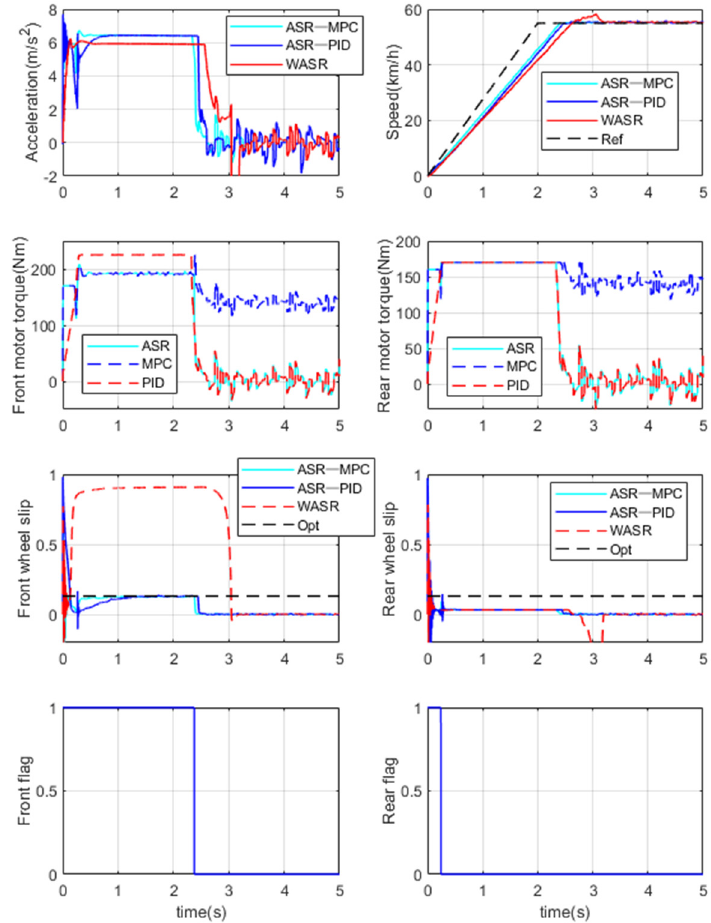
Figure 8. Vehicle starts under a high adhesion coefficient road. As shown by the results, ASR-MPC and ASR-PID are more dynamic than WASR and has a faster speed response. In ASR-MPC control, the NMPC is turned on when vehicle speed is greater than v min , and the front wheel slip rate can effectively track the optimal slip rate. However, the rear wheel slip rate cannot track the optimal slip rate, because the load is transferred backward during the acceleration process, and the rear axle wheels require a larger motor torque to generate the same slip rate. The slip rate cannot continue increasing due to the limitation of the motor torque. The control effect of ASR-PID is basically consistent with that of ASR-MPC. In WASR control, the wheel slip rate is large at 0.2–3 s. The handling stability of the vehicle is considerably reduced at this time. This condition is more dangerous, and the rear wheel slip rate is always kept at a small value due to load transfer. When speed is greater than v min , the slip rate can track the optimal slip rate if flag = 1, and the slip rate remains below the optimal slip rate if flag = 0. Therefore, the designed algorithm can also play an important role in a road surface with a high adhesion coefficient. The expected results can be achieved regardless of the starting and